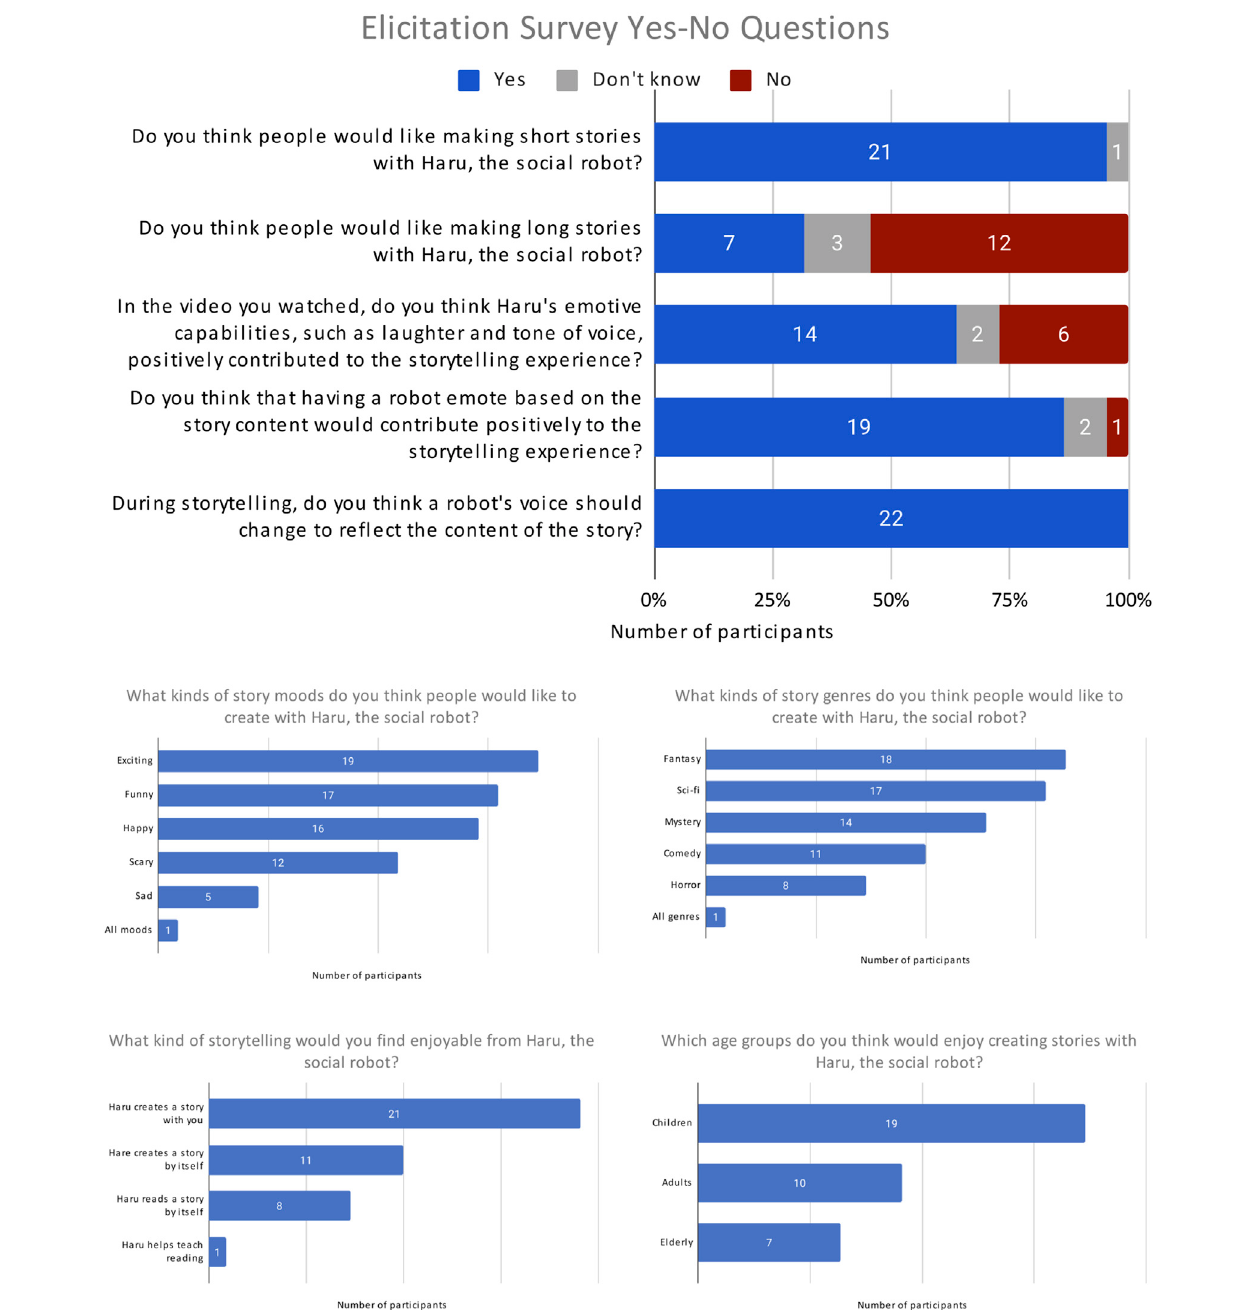
FIGURE 9 | Questions and responses from the elicitation